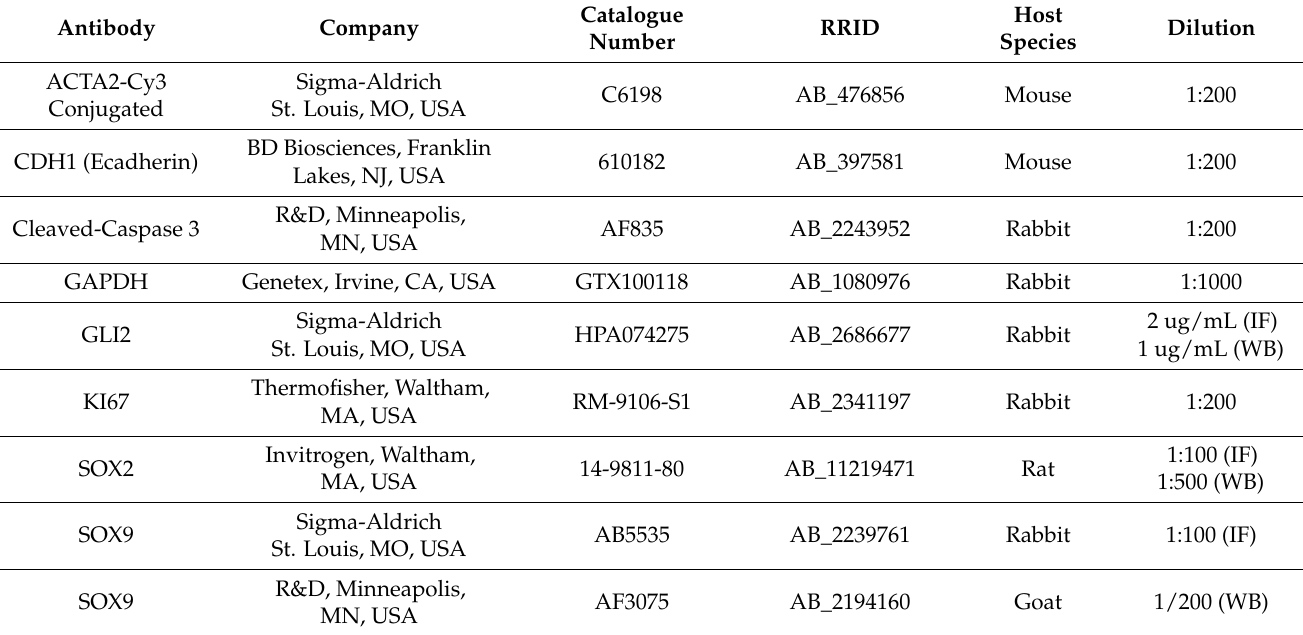
Table 2. Antibodies used in immunofluorescence and western